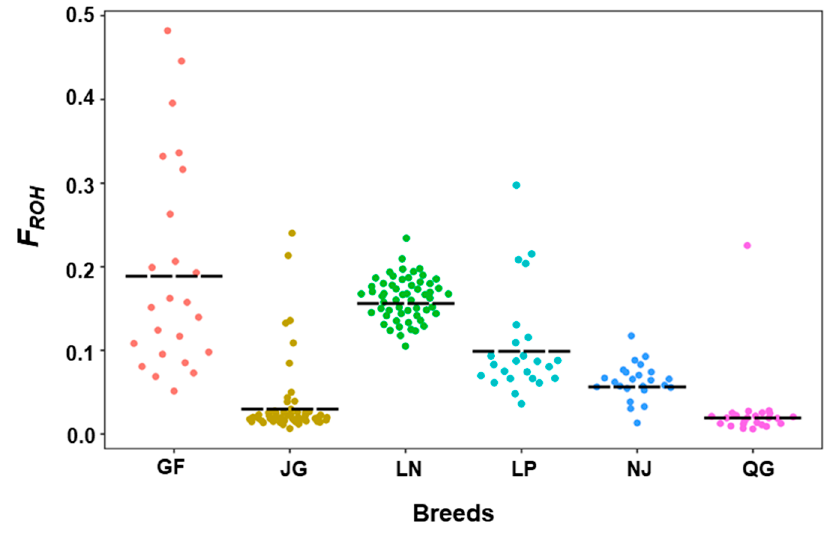
Figure 6. Distribution of the runs of homozygosity inbreeding coefficient ( F ROH ) within each breed.